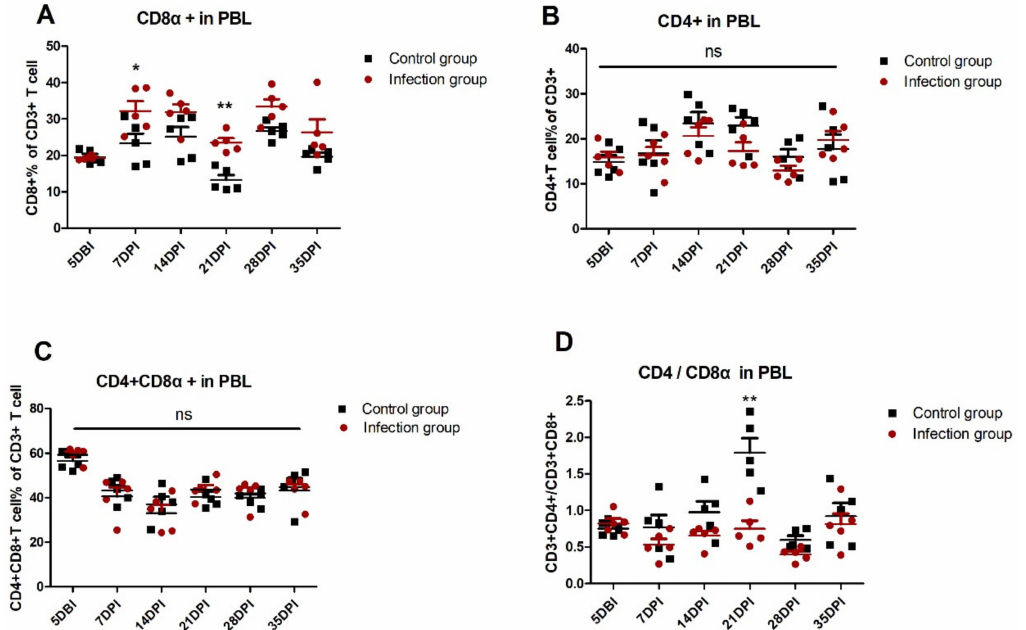
Figure 2. Dynamic detection of T lymphocyte percentage in peripheral blood lymphocytes (PBL). Five days before infection (DBI) and each week after infection, PBL derived from five chickens of infected of ( A ) the CD3 + CD8 + T cell, ( B ) CD3 + CD4 + T cell, and ( C ) CD3 + CD4 + CD8 + . ( D ) The ratio of CD3 + CD4 + / CD3 + CD8 + was detected. Each sample collected 1 × 10 5 cells for flow cytometric